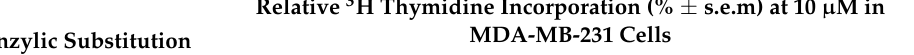
Table 1. Relative 3 H thymidine uptake by MDA-MB-231 cells after treatment with 10 µ M of each inhibitor. (green) Compounds that exhibited 60–70% inhibition of cell growth; (blue) compounds that exhibited 70–80% inhibition of cell growth; (red) compounds that exhibited >80% inhibition of cell growth. ** p < 0.01, *** p < 0.001 when compared to their corresponding non-nitrosylated benzylamine partners by Student’s unpaired t -test.